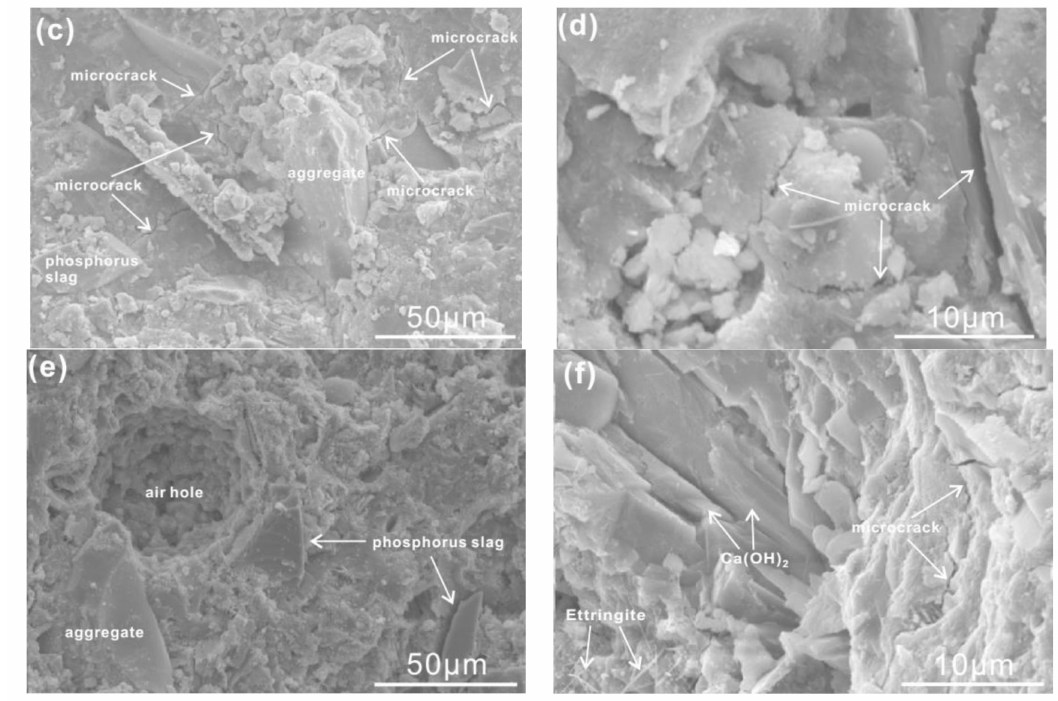
Figure 12. SEM images of cement mortars at di ff erent ages. ( a , b ) Plain mortars at 3 days and 28 days; ( c , d ) cement mortars with 30% by mass of phosphorus slag at 3 days and 28 days; ( e , f ) cement mortars with 30% by mass of phosphorus slag and the chemical activator at 3 days and 28